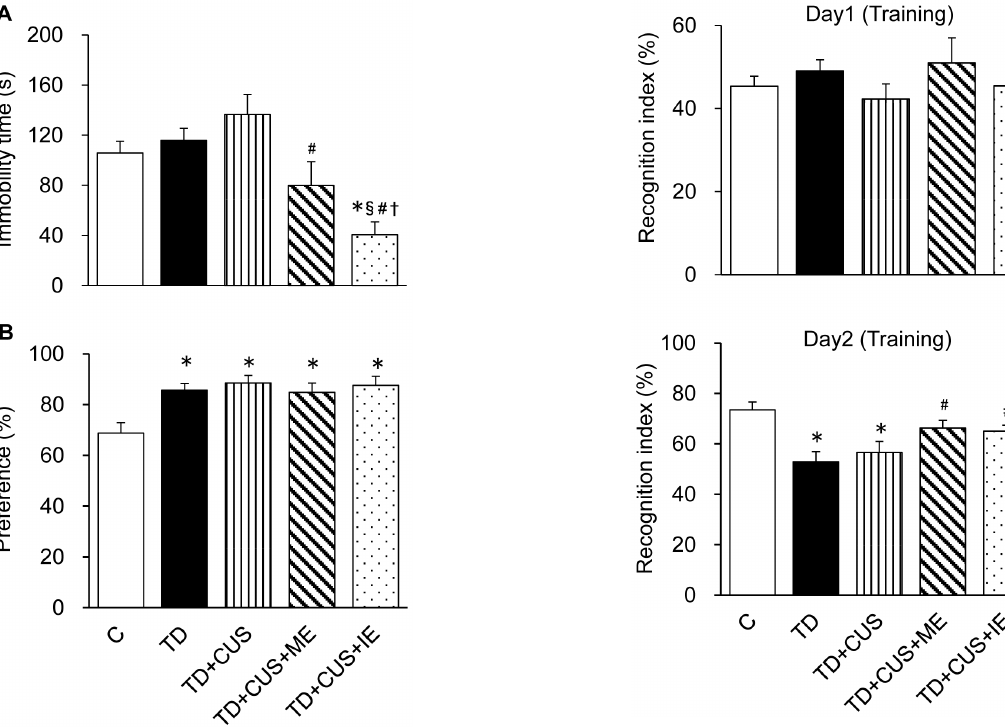
Figure 4. Effects of tryptophan deficiency, CUS and regular exercise in FST (a) and SFT (b). Data are expressed as mean 6 SEM. *, p , 0.05 vs. C; 1 , p , 0.05 vs. TD; # , p , 0.05 vs. TD + CUS; { , p , 0.05 vs. TD + CUS + ME.